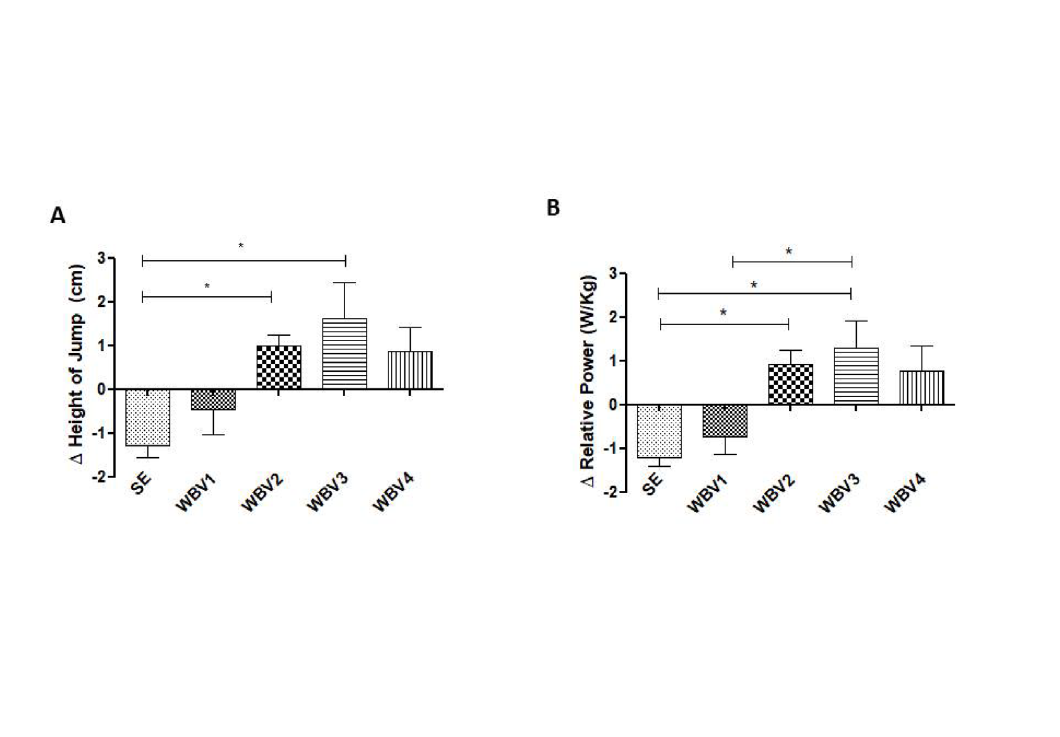
Figure 2 - The change (Δ = Post – Pretest) in jump height (A) and jump relative power (B) among the experimental conditions. * Significantly different with P < 0.05 (N=9).